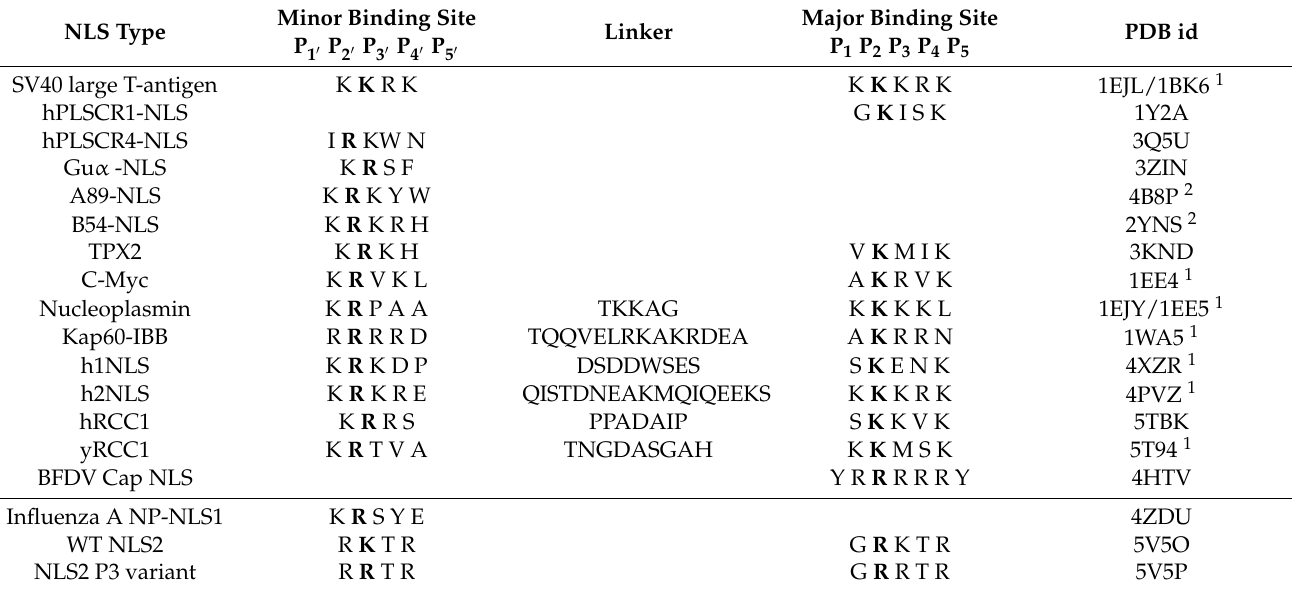
Table 5. Alignments of several NLSs indicating their binding to importin- α deduced from the crystal structure of importin- α in complex with the